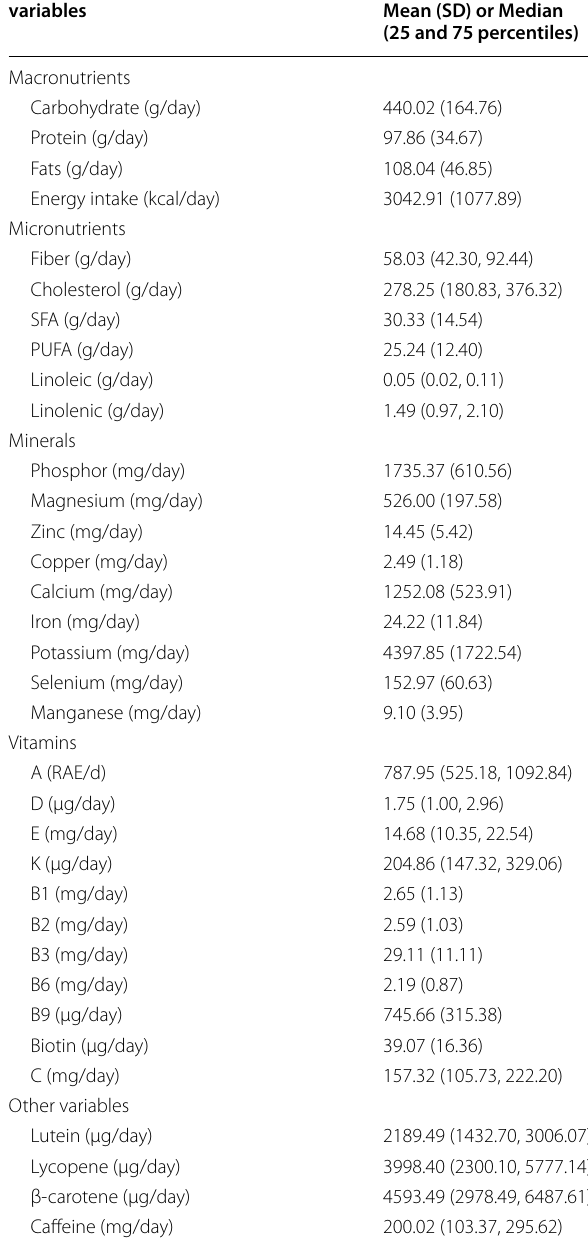
Table 2 Daily macro- and micronutrient intakes of the study